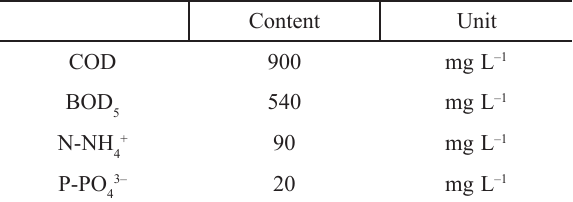
Table 1 – Composition of model wastewater (N and P